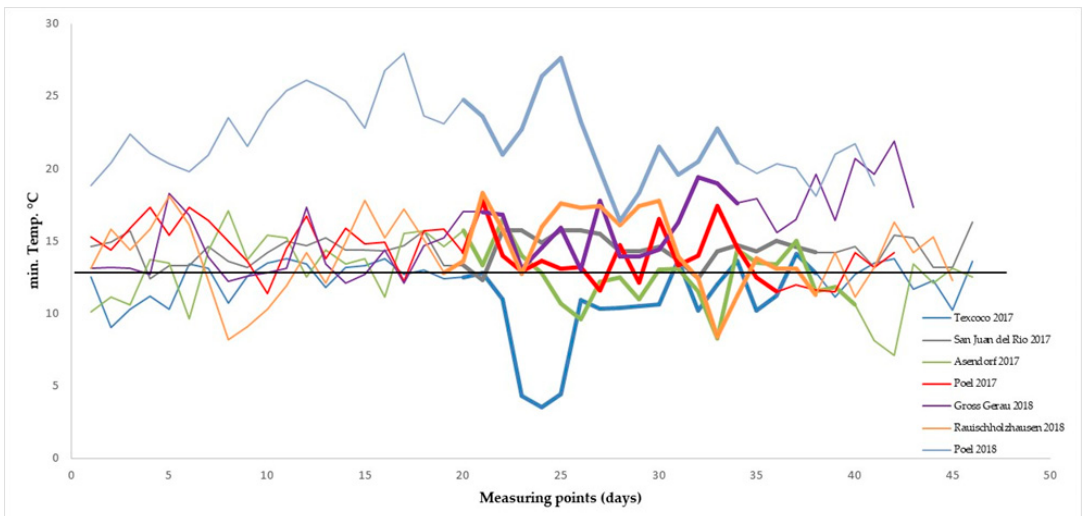
Figure 1. Course of minimum temperatures at the di ff erent environments, shown for the time period between 20 days before anthesis of the earliest entry and seven days after anthesis of the latest-flowering entry. The duration of anthesis at the respective locations is indicated by bold graphs. The black horizontal line indicates 13 ◦ C.